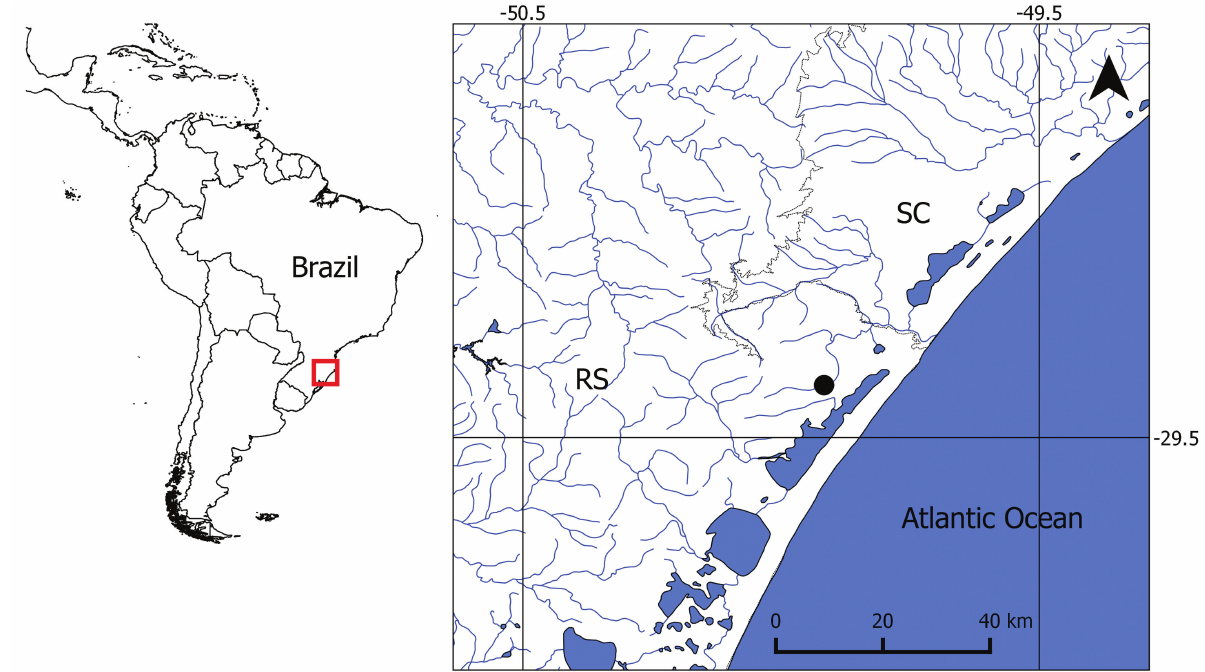
Fig. 1. Location of the sampling site of Deuterodon stigmaturus (black dot) in the Paraíso stream, a tributary of the Mampituba River in Southern Brazil coastal region, between Rio Grande do Sul (RS) and Santa Catarina (SC)